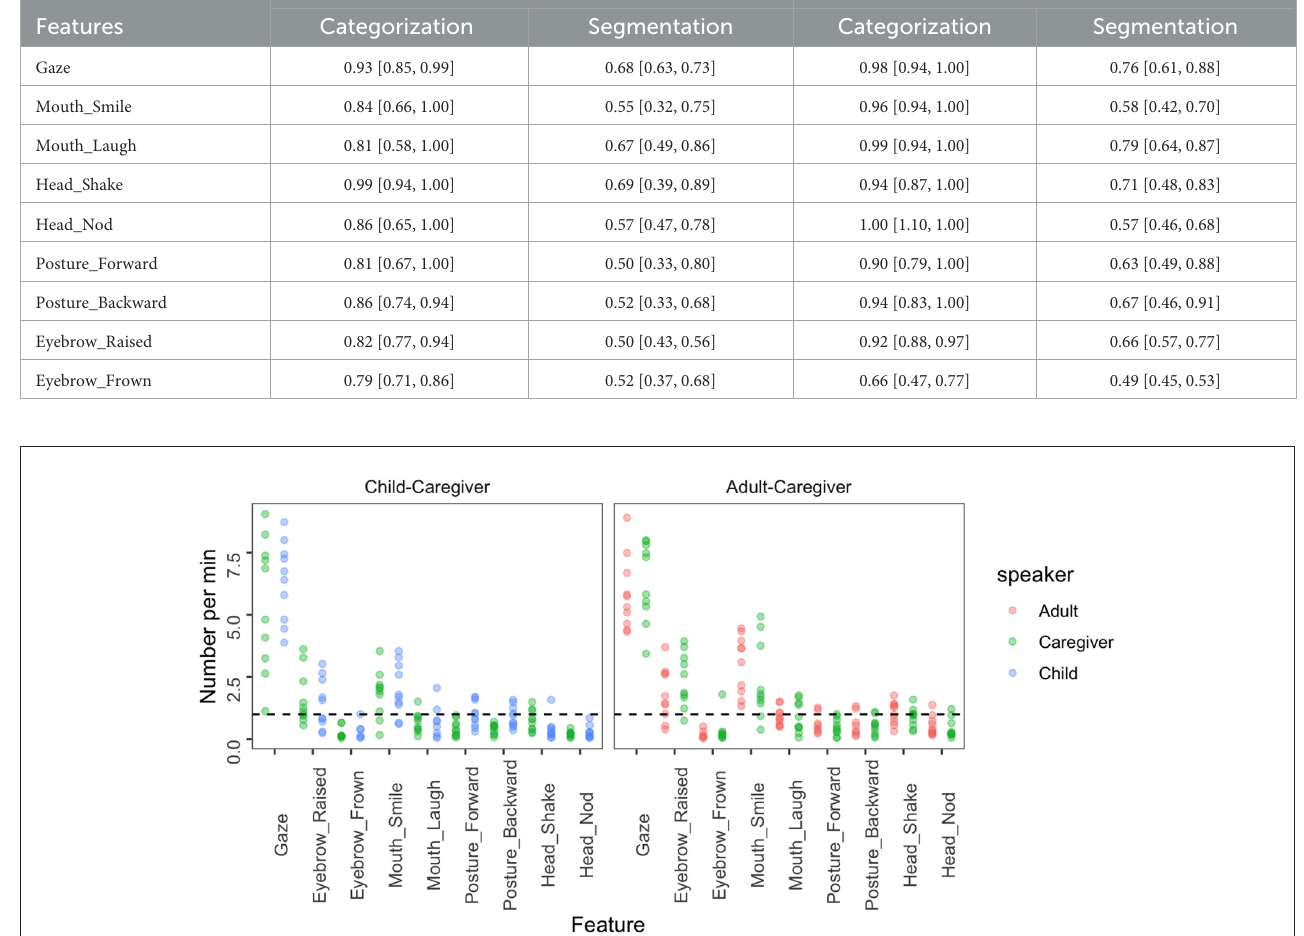
TABLE 1 Average gamma scores quantifying inter-rater reliability between two annotators using 20% of the corpus. Ranges the indicate lowest and largest gamma in the videos annotated in each age group. Children Adults